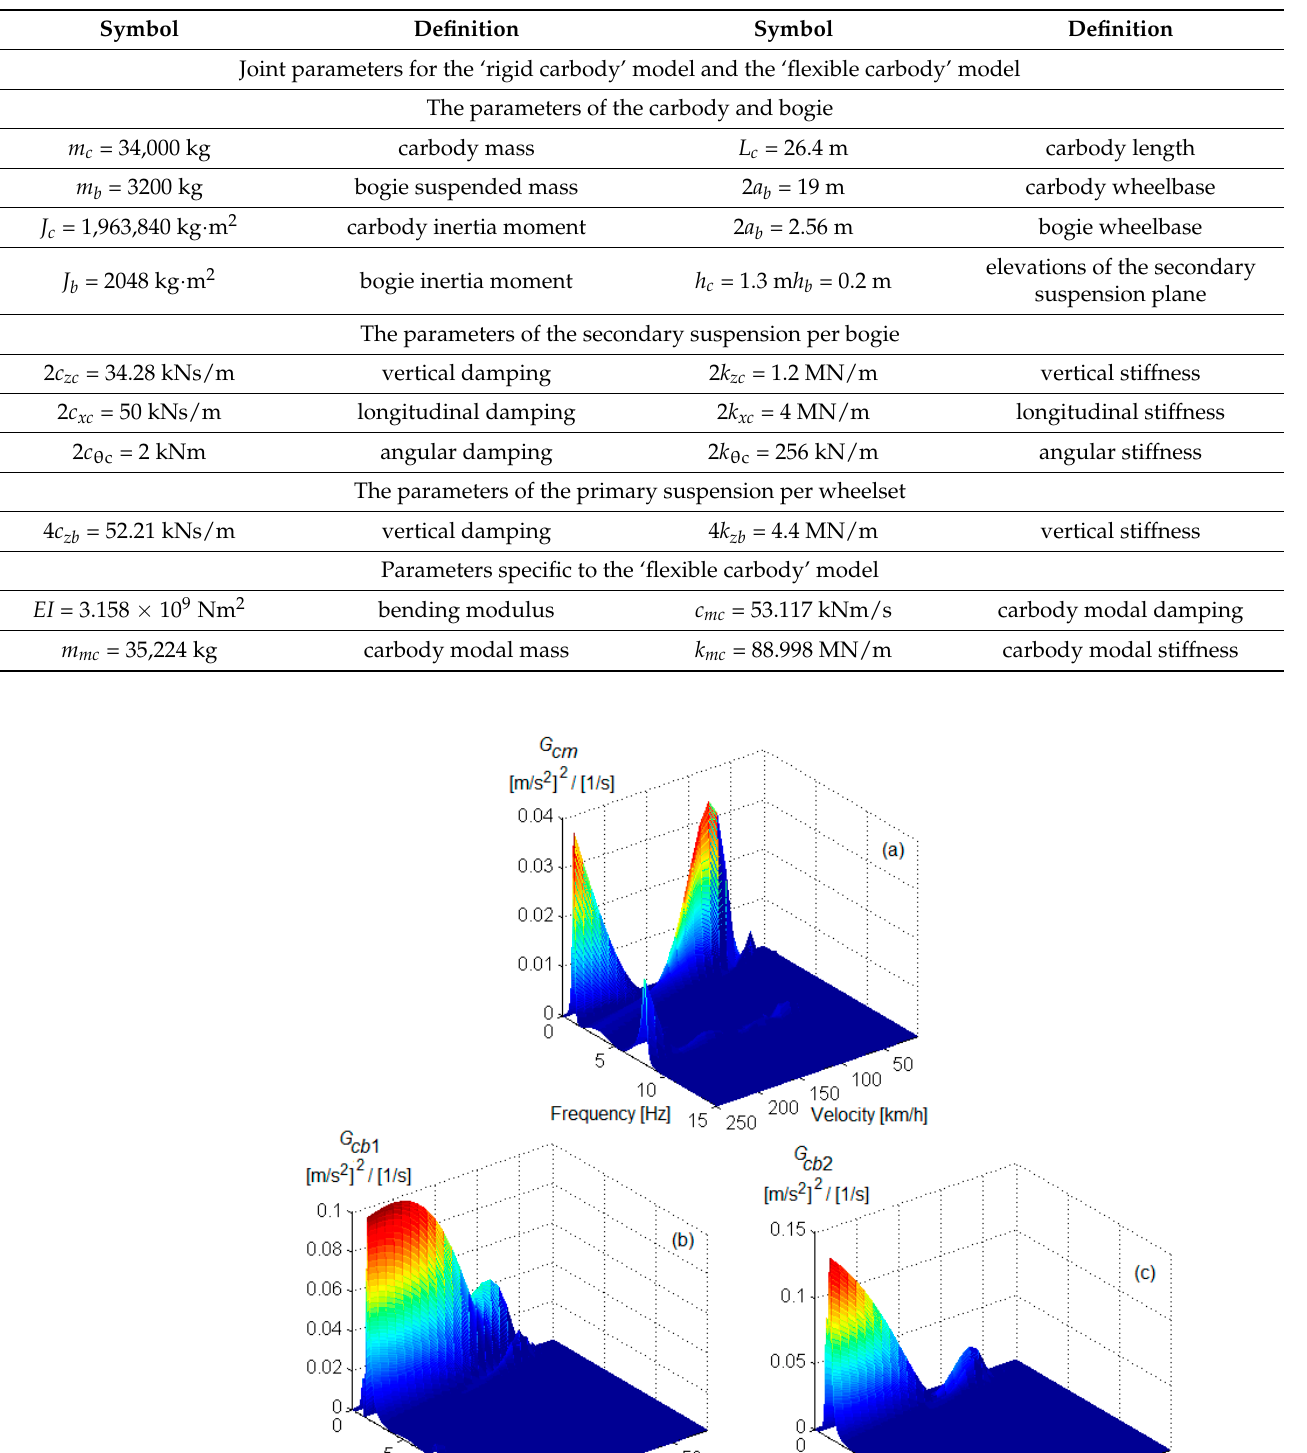
Table 1. Reference parameters of the vehicle model.